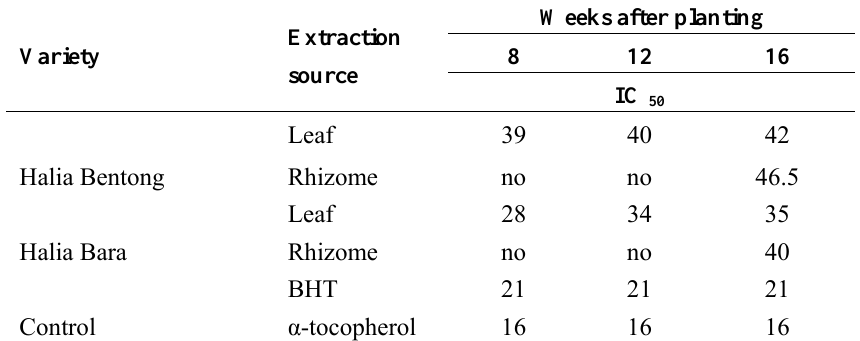
BHT Control Results expressed in µg/mL of concentration. no: not